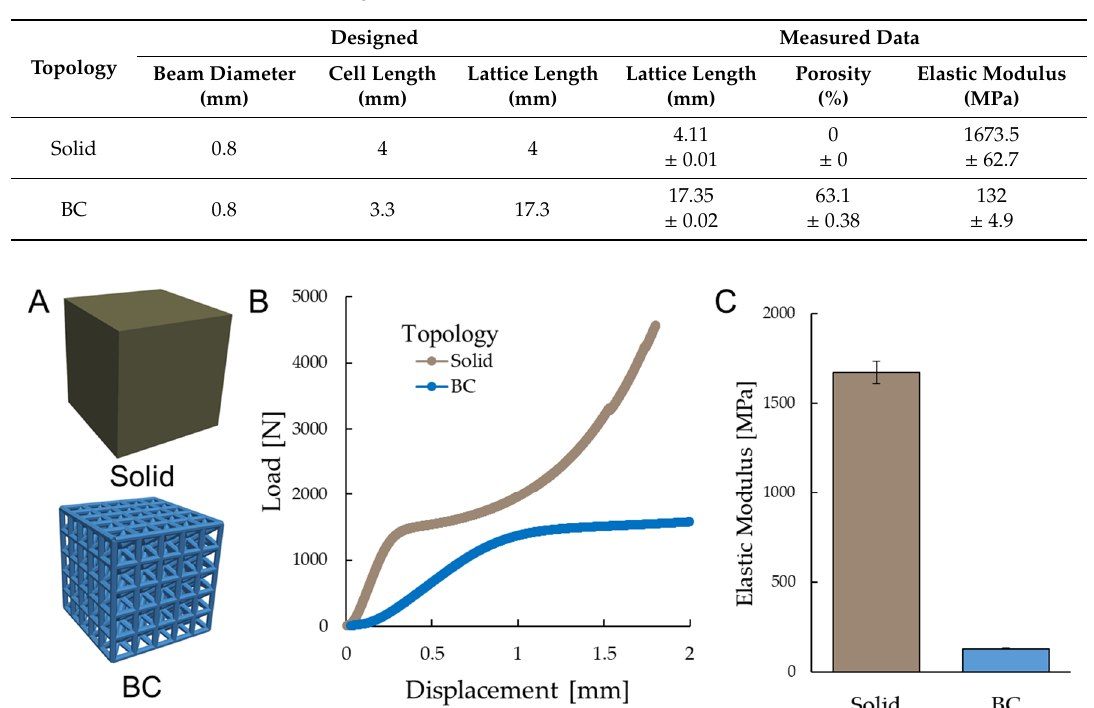
Table 1. Design and measurements for material characterization.